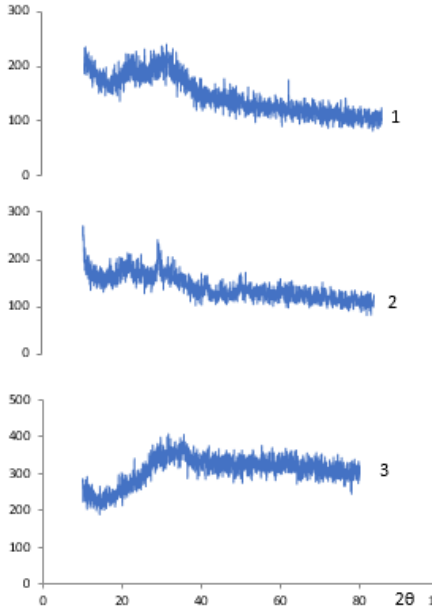
Figure 5. X-ray diffraction analysis of the TiSi-powder fractions prepared at steam blowing at 400 °С (1), 600 °С (2), and 800 °С (3) (Cu Kα).